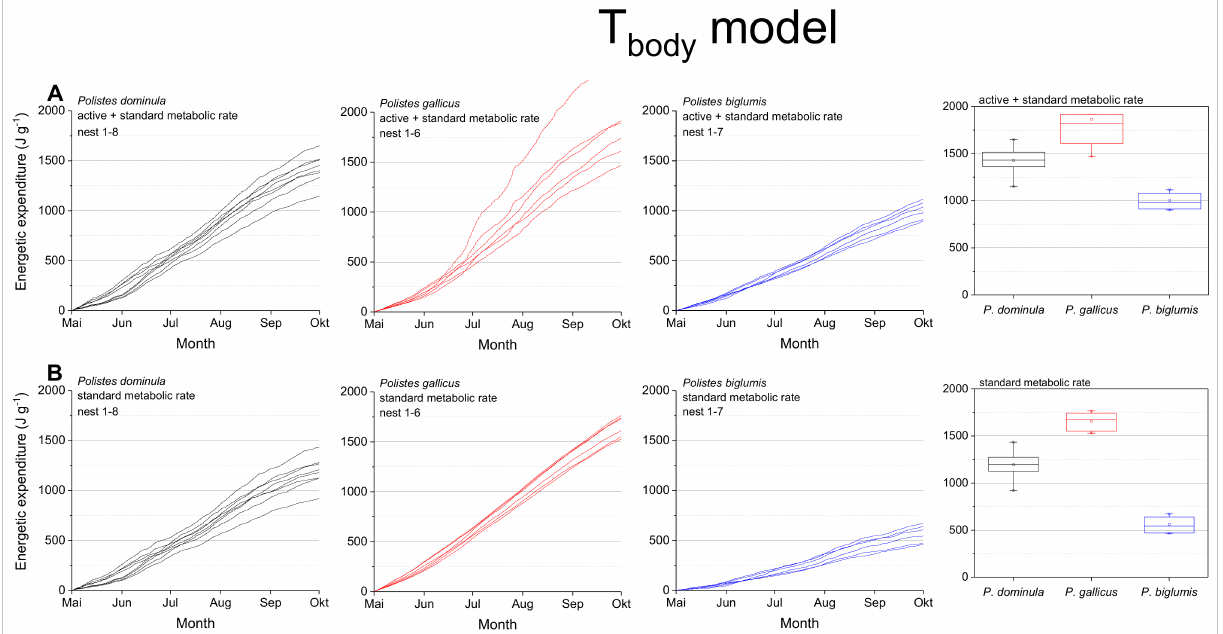
Figure 4. T body model: Mass specific energetic expenditure of paper wasps during a breading season, calculated with models of the wasps’ body temperature (T body ; [4]) and metabolic rate-temperature models [17,29]. ( A ) Mixed activity (MMR, mean of active and standard metabolic rate) and ( B ) resting wasps (SMR, standard metabolic rate). Box and whisker plots represent median costs with first and third quartiles summed for the breeding season (May–October); dots in plots are